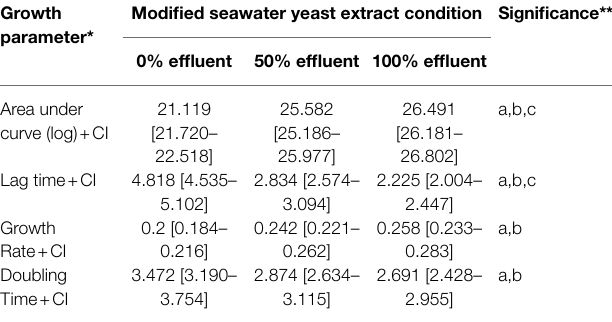
TABLE 1 | Growth rate of Vibrio vulnificus in 0, 50, and 100% wastewater treatment plant (WWTP) effluent condition. Growth